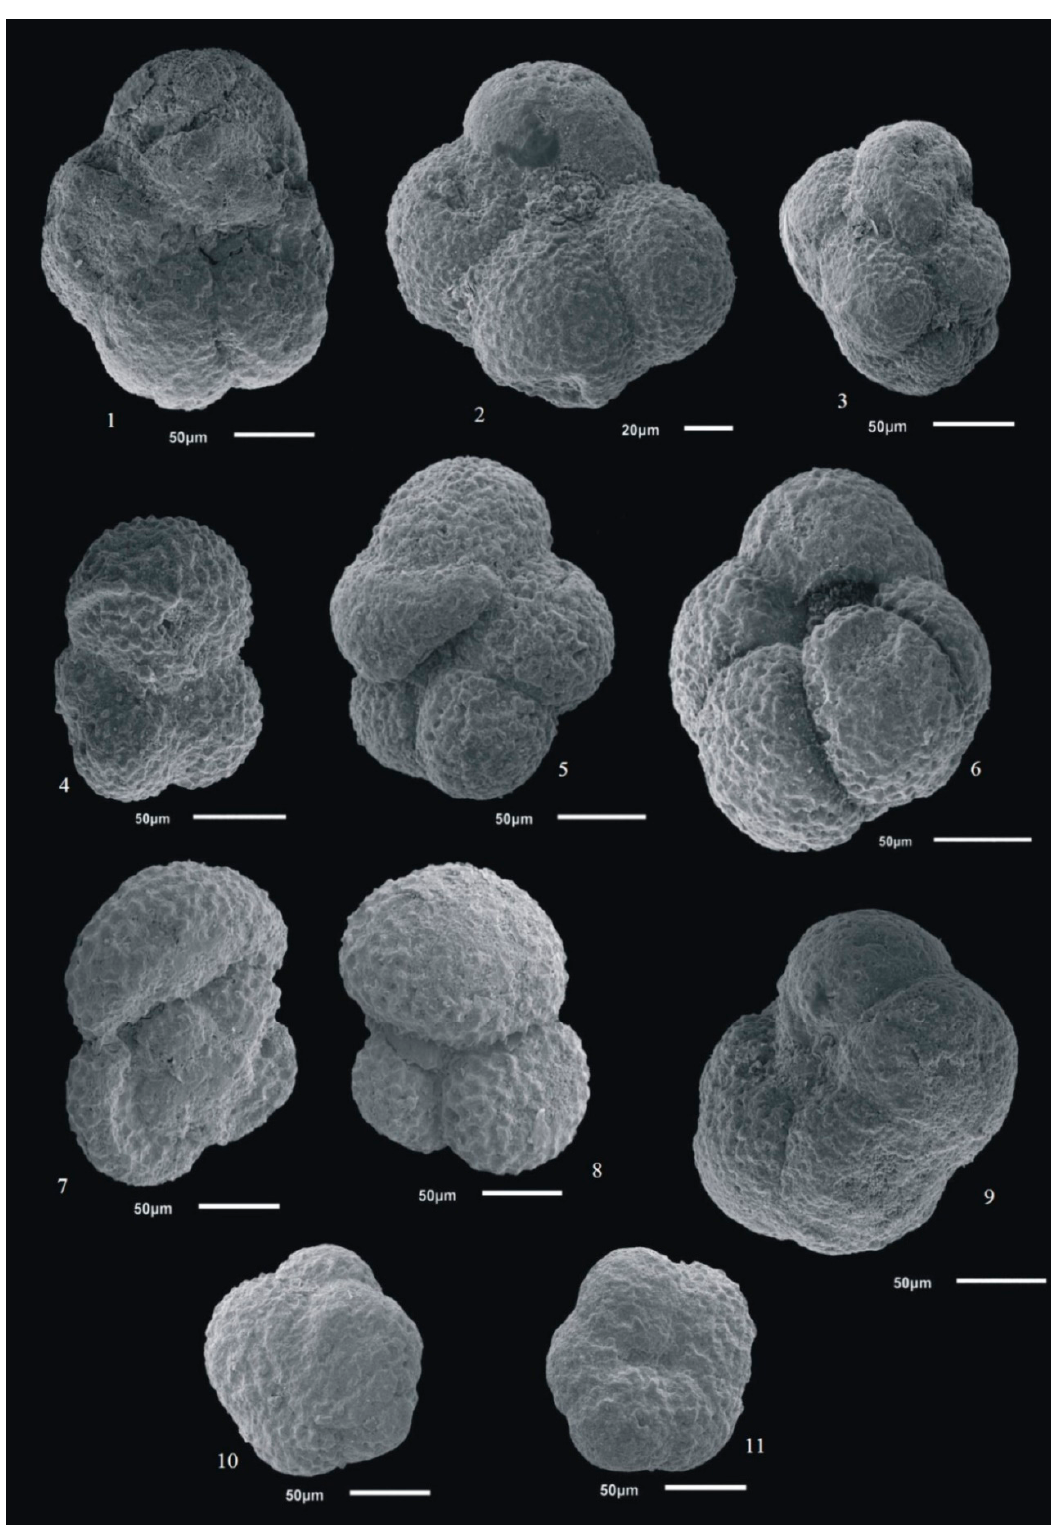
Figure 4. Planktonic foraminifera identified in the gypsum sample (SEM photos, continuation): (1). Tenuitella angustiumbilicata (Bolii); (2). Globigerinita aff. glutinata (Egger); (3). Globigerinita uvula (Ehrenberg); (4). ? Globigerina praebulloides Blow; (5). Globigerina sp. (with bullae); (6). Globorotalia sp.1; (7,8). Globigerinoides sp.; (9); Globorotalia sp.2; (10,11); Paragloborotalia sp. 1.